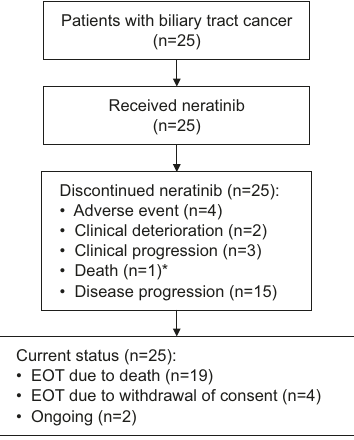
Fig. 1 | Study fl ow. *Death was due to progressive disease. EOS end of study.